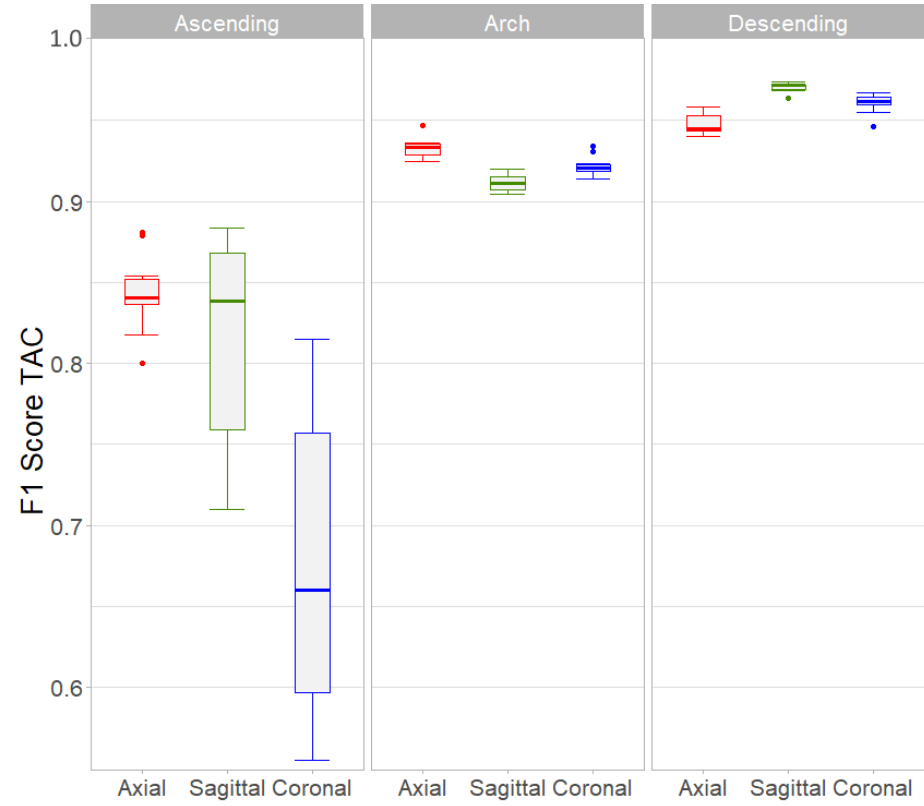
Figure 4. Boxplots of F1-Score weighted by TAC for each of the three single-input architectures on each of the three aortic segments. The Axial architecture was the best in the ascending and arch portions, whereas the Sagittal architecture had a better performance for the descending